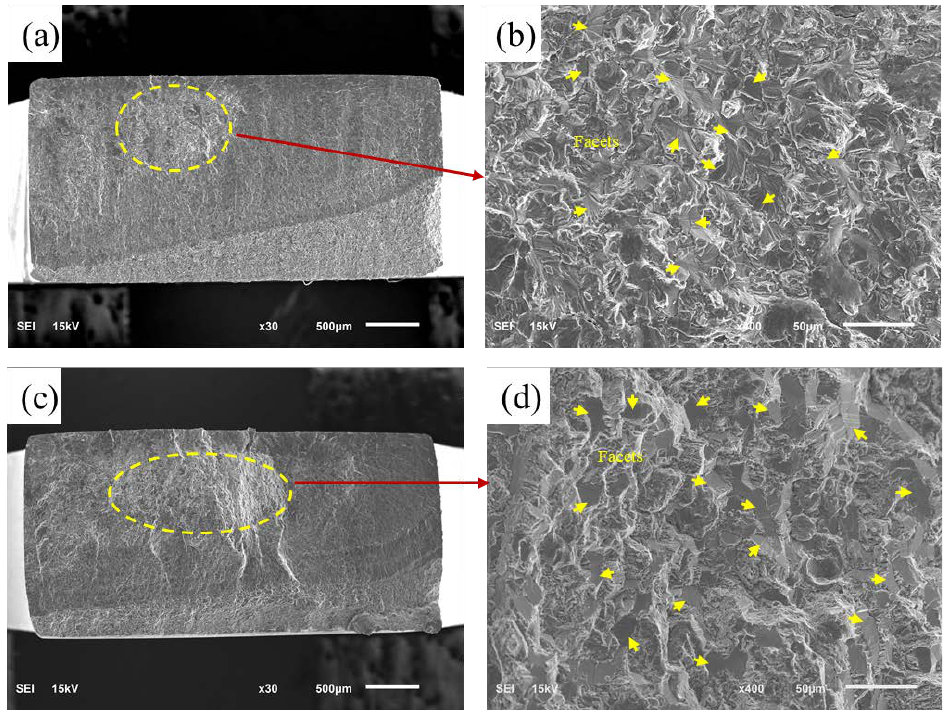
MPa, ; Figure 11. Typical fracture morphology in the VHCF: ( a , b ) Figure 11. Typical fracture morphology in the VHCF: ( a , b ) σ a = 246.66 MPa, N f = 9.91 × 10 7 ; 7 MPa, cycles. ( c , d ) ( c , d ) σ a = 213.1 MPa, N f = 2.53 × 10 8 𝜎𝜎 𝑎𝑎 = 246.66 𝑁𝑁 𝑓𝑓 = 9.91 × 10 8 𝑁𝑁 𝑓𝑓 = 2.53 × 10 𝜎𝜎 𝑎𝑎 = 213.1